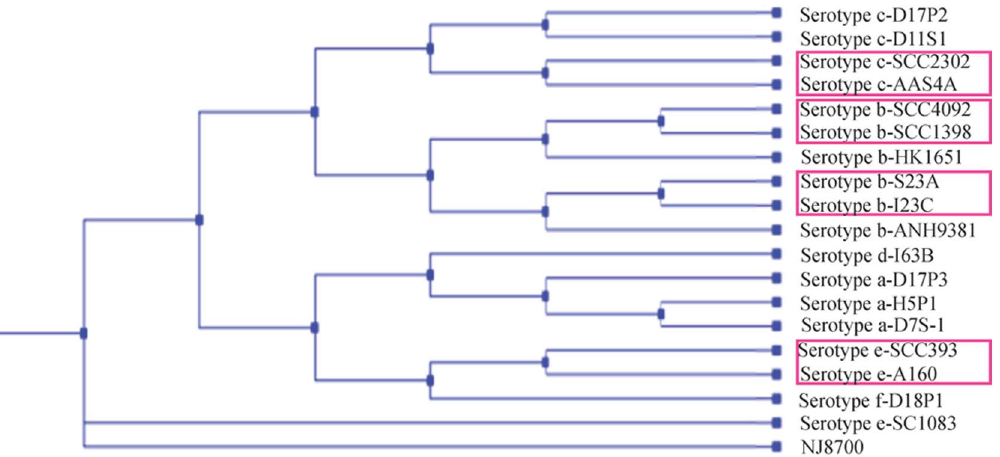
Figure 1. Cladogram of 18 A.actinomycetemcomitans strains and A.aphrophilus NJ8700 based on 150 core genes. In the cladogram, the paired strains (bracketed by red boxes) were more closely related to each other than to any other strain, indicating that they derived from the same ancestral strain through recent evolution.